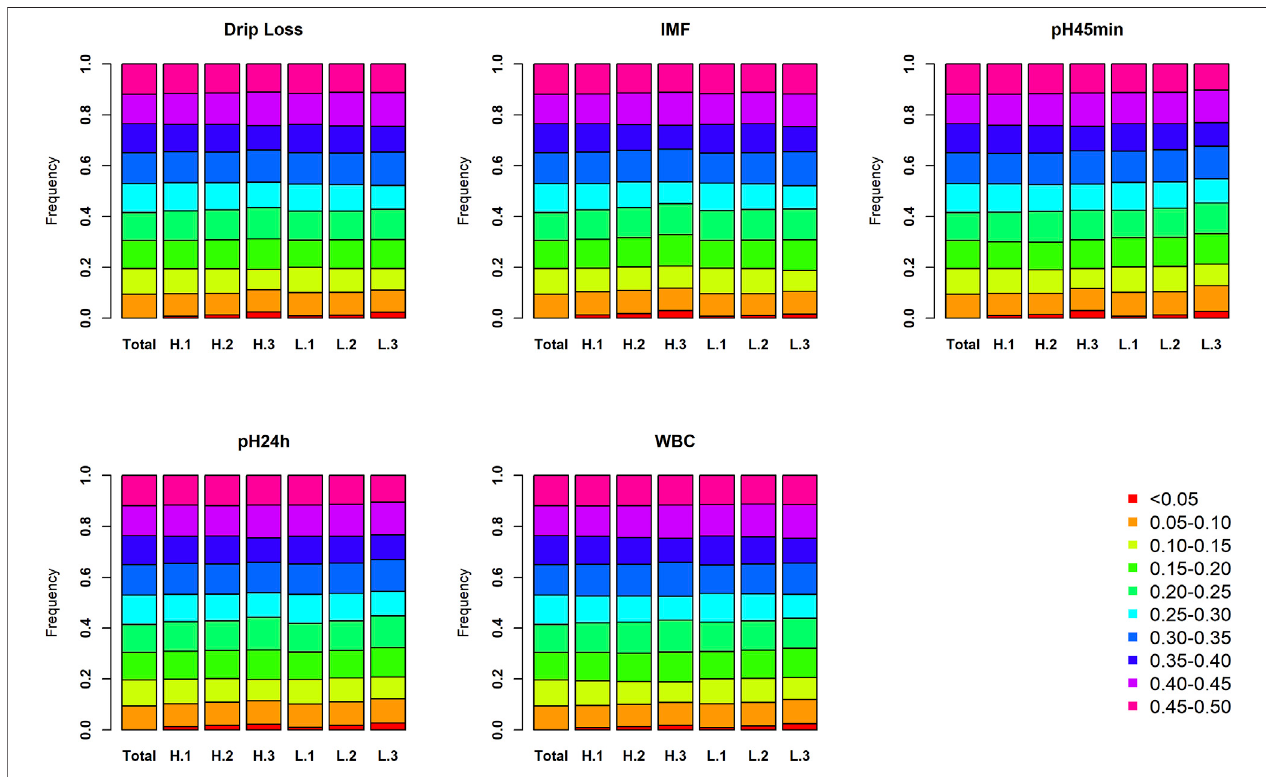
FIGURE 2 | The proportion of each MAF bin in each subpopulation for fi ve meat quality traits. The total represents the proportion of each MAF bin in source population. Similarly, H.3 (H.2, H.1) and L.3 (L.2, L.1) represent the proportion of each MAF bin in the two subpopulations of third (second and fi rst) population pair.